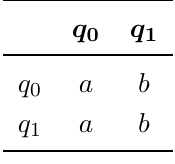
Figure 3. The automaton that corresponds to Player 1. In the case of Player 2, the accepting state is the state q . 1 Table 1. Transition matrix of the automaton of Figure